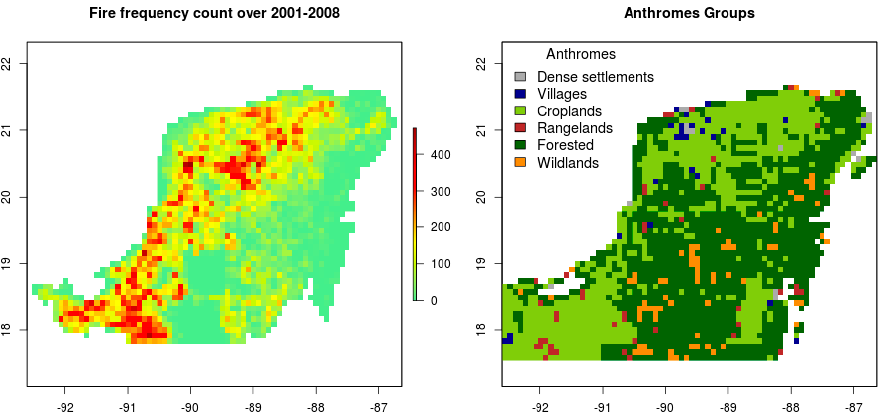
Figure 6. Fire frequency aggregation for anthrome comparison ( left ) and Anthrome groups ( right ).